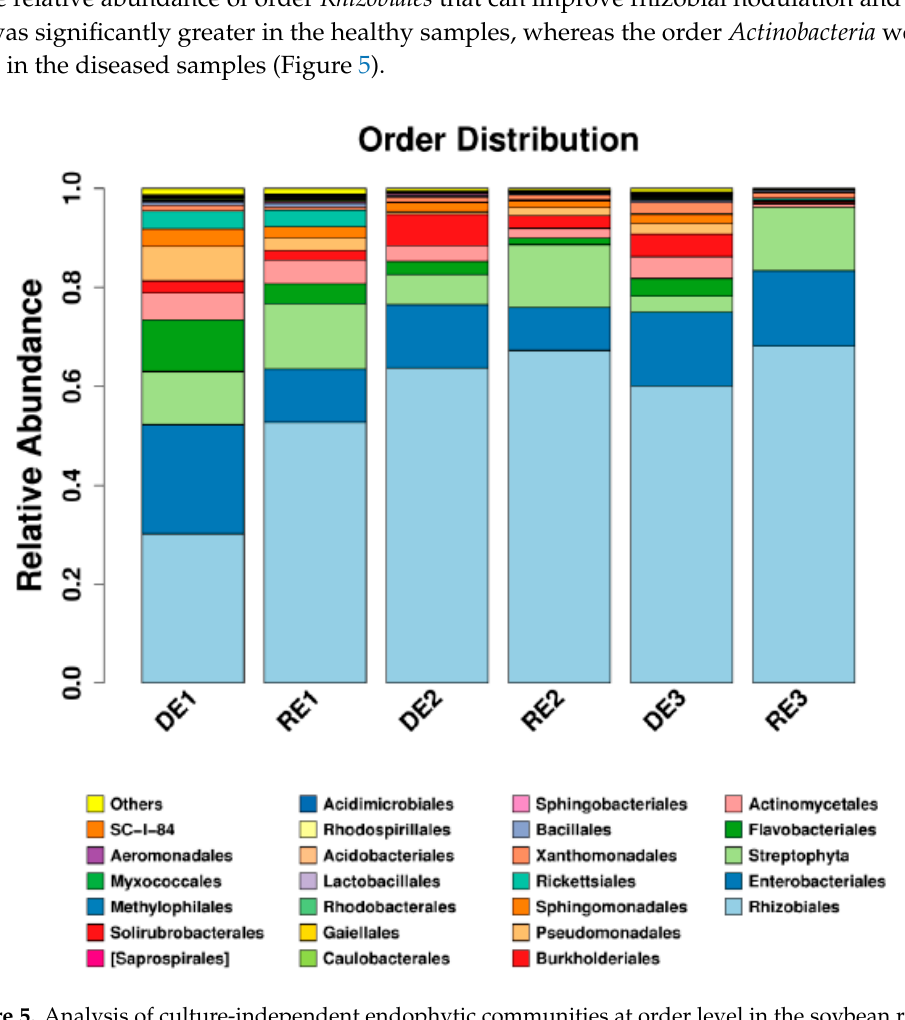
Figure 5. Analysis of culture-independent endophytic communities at order level in the soybean roots. DE, diseased sample; RE, healthy sample.